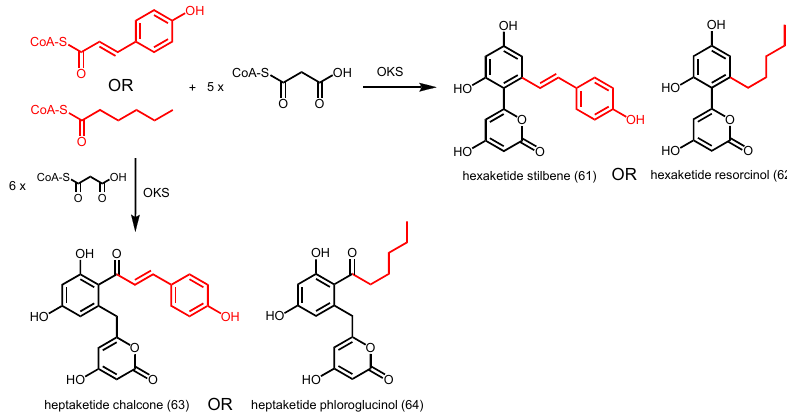
Scheme 22. Synthesis of various polyketides catalyzed by A. arborescens OKS.